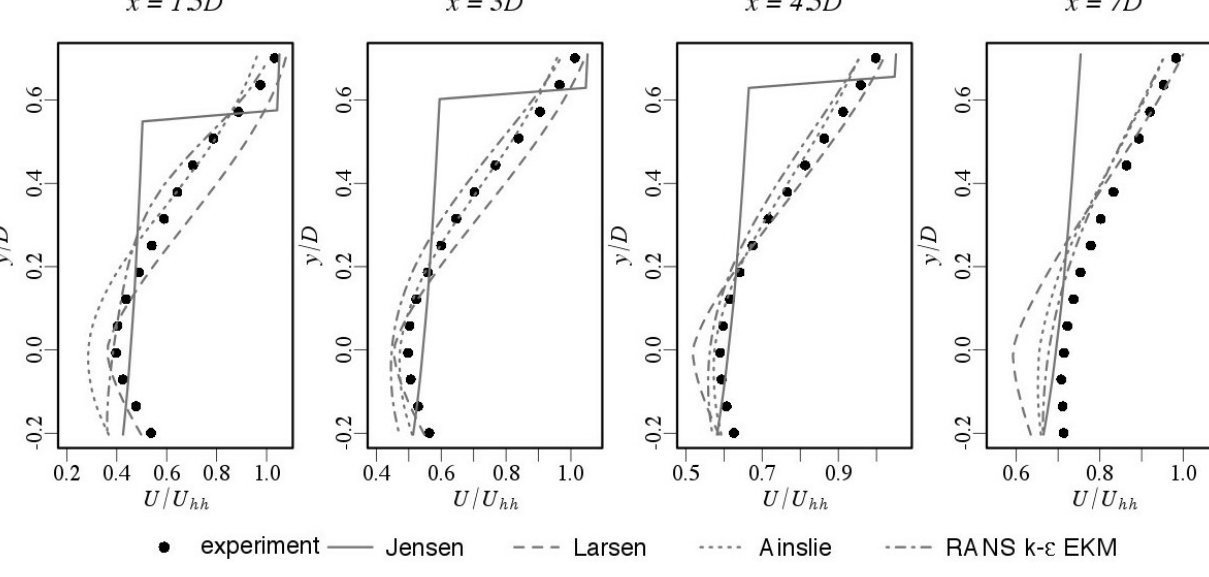
with various wake models for hh